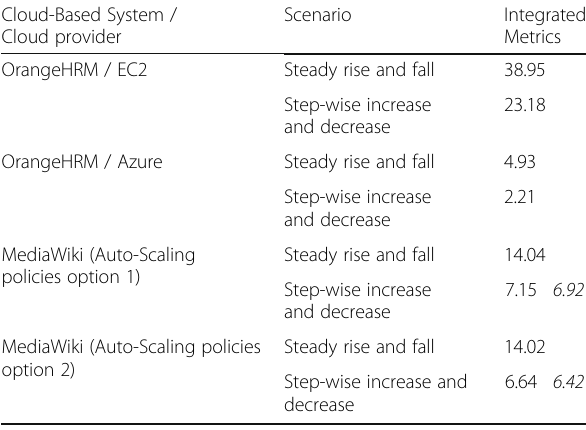
Table 8 Integrated scalability metric values Cloud-Based System / Cloud